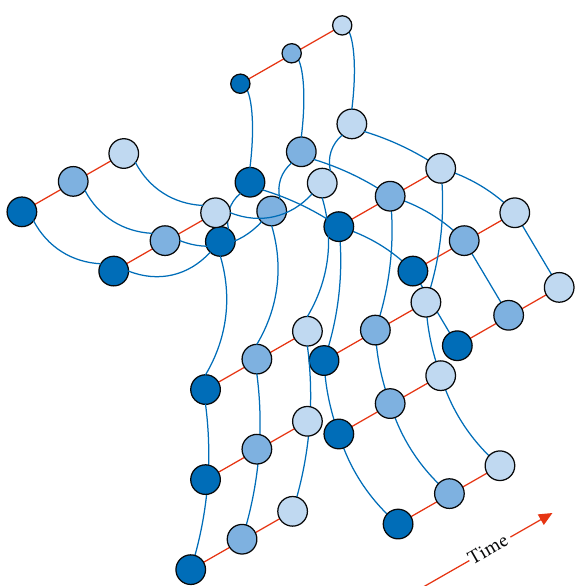
Figure 2: Schematic diagram of skeleton spatiotemporal graph.